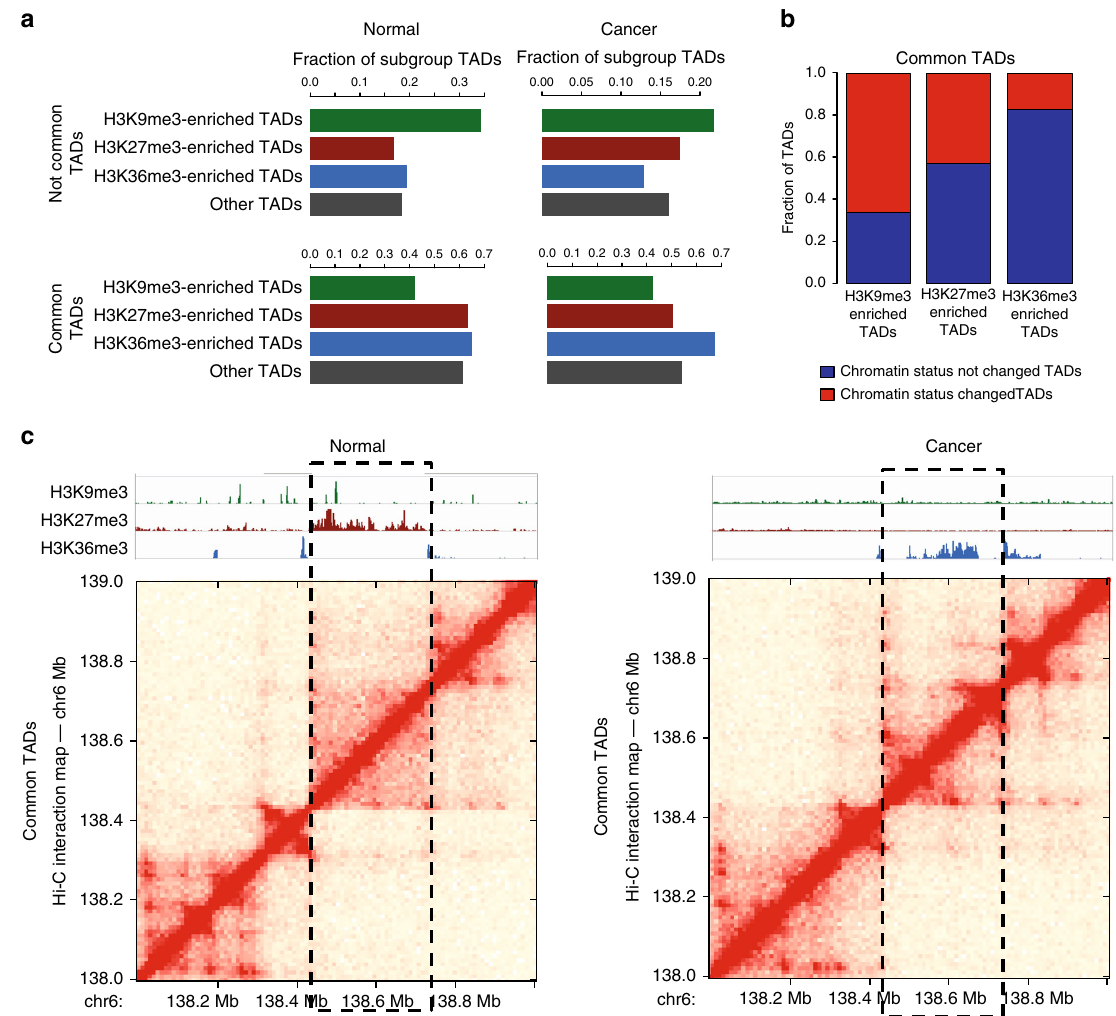
Fig. 3 Identi fi cation of TADs that change epigenetic states in prostate cancer cells. a Top: fraction of histone mark-enriched TAD subgroups in normal- speci fi c TADs (RWPE1) and cancer-speci fi c (C42B) TADs. Bottom: fraction of histone mark-enriched TAD subgroups in common TADs (left: normal (RWPE1), right: cancer (C42B)). b Shown is the fraction of common TADs whose chromatin status changed (red) and did not change for each histone mark-enriched TAD subgroup (blue); the initial epigenetic status of each TAD was from normal (RWPE1) cells. c Shown is an example of a common TAD located at chromosome 6q23 that changed epigenetic status between normal and prostate cancer cells. Dashed lines indicate the same TAD boundaries in both the normal and cancer